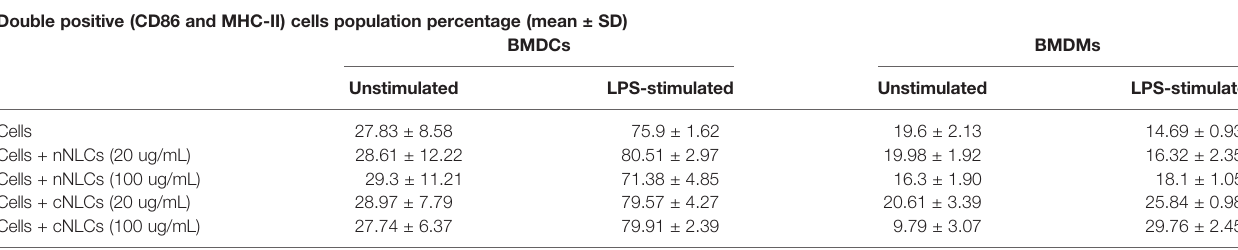
TABLE 2 | Percentage of activated APCs with or without NLCs treatment.